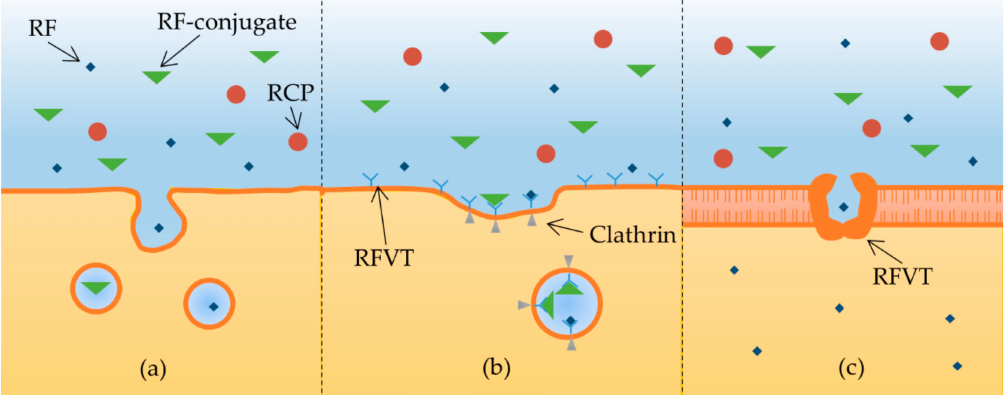
Figure 2. Internalization pathways: ( a ) pinocytosis; ( b ) clathrin-mediated endocytosis; ( c ) carrier-mediated transport. Abbreviationsaredefinedasfollows: riboflavin(RF);riboflavintransporter(RFVT);riboflavin carrier protein